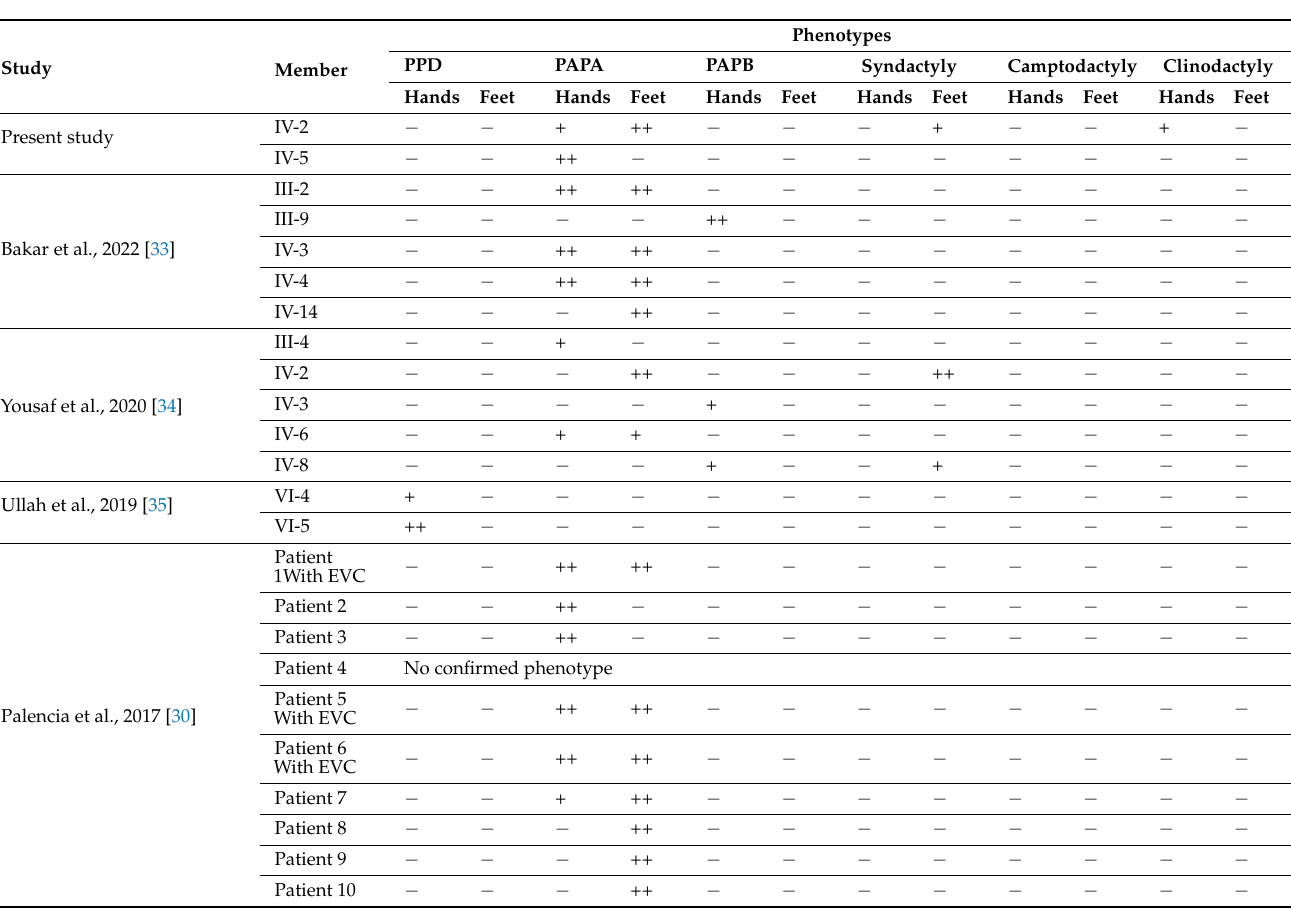
Table 6. Phenotypic comparison of the patients in the present study with previously reported patients with pathogenic variants in GLI1